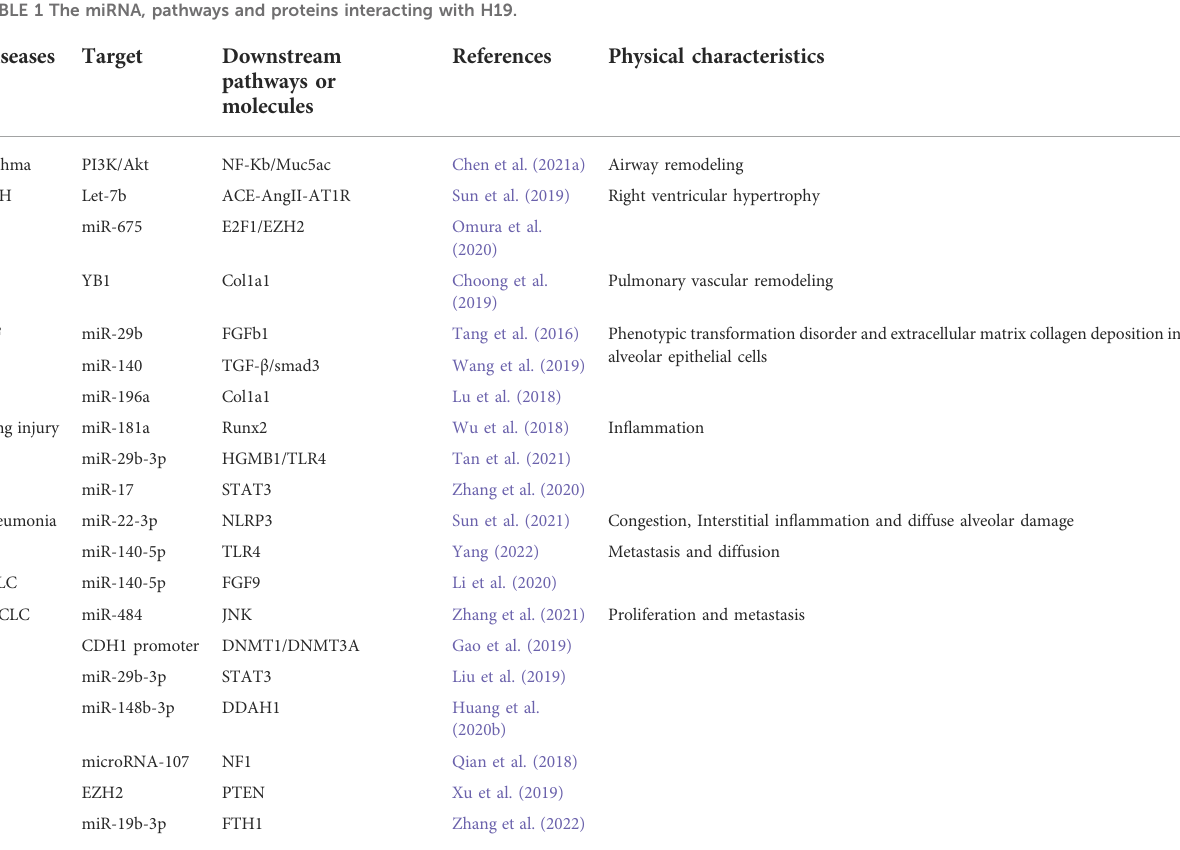
TABLE 1 The miRNA, pathways and proteins interacting with H19. Diseases